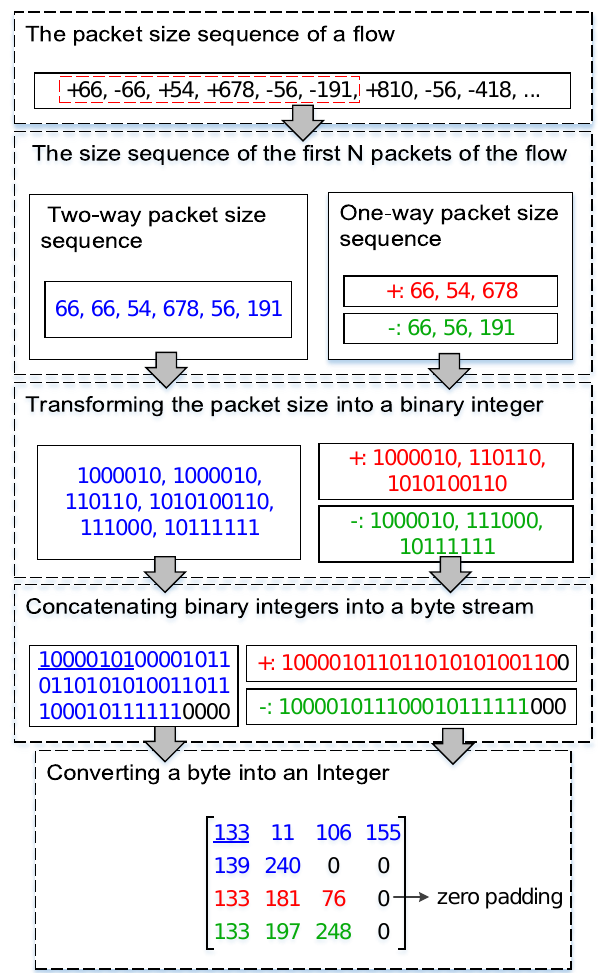
Figure 2. The image conversion process of the